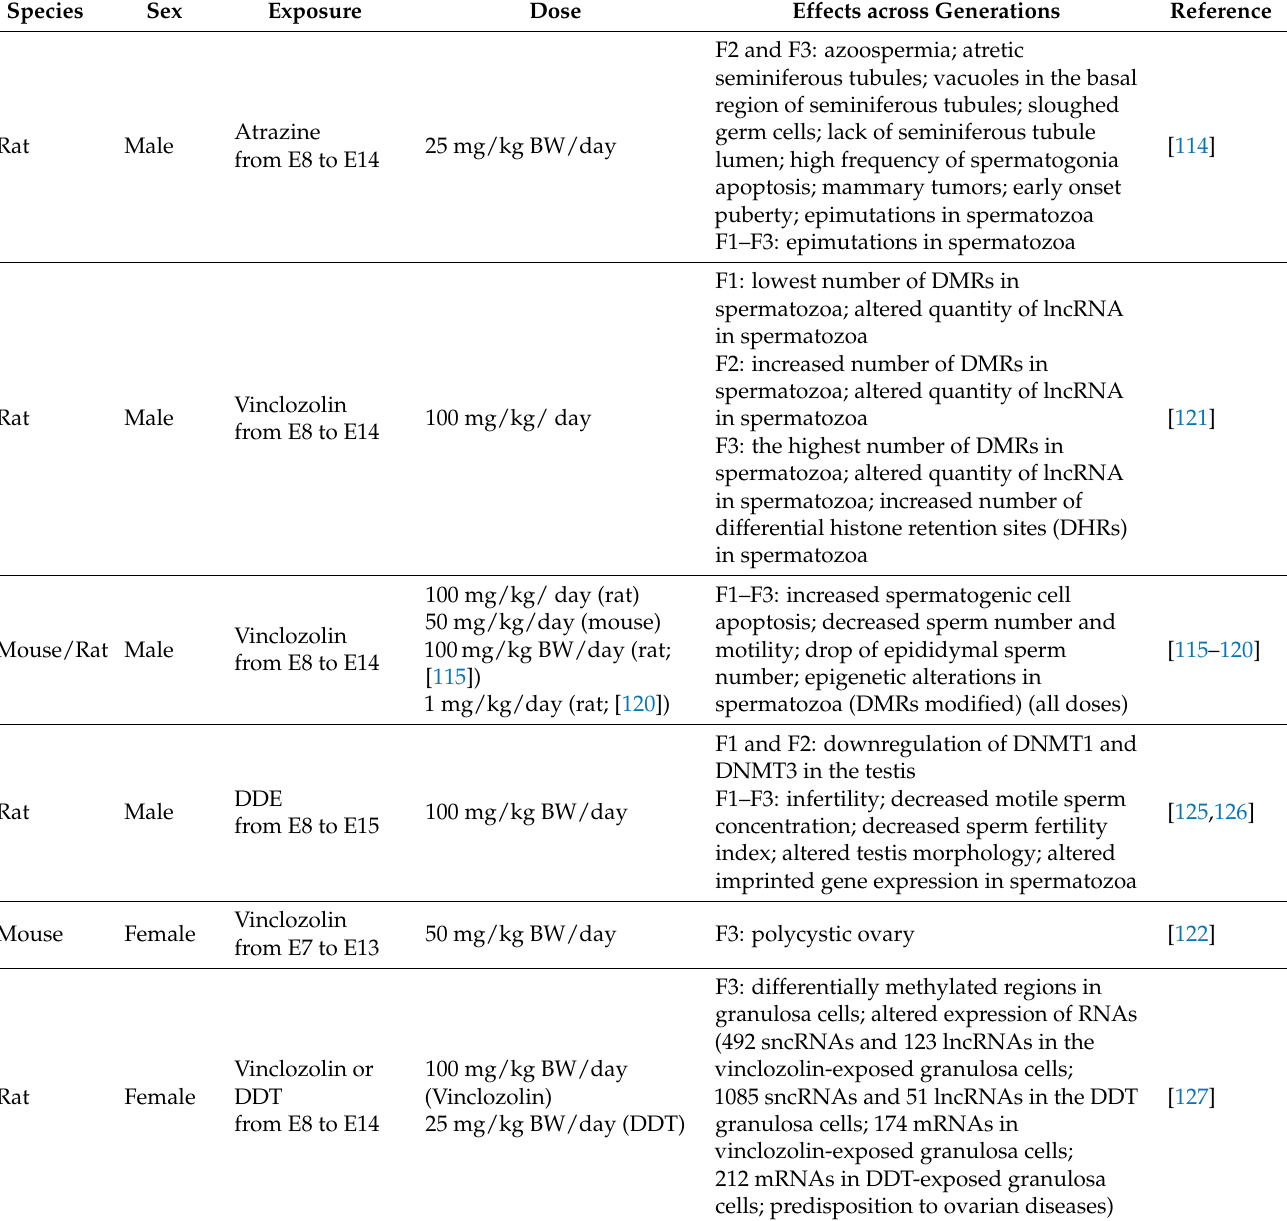
Table 4. Pesticide-induced effects in model animals across